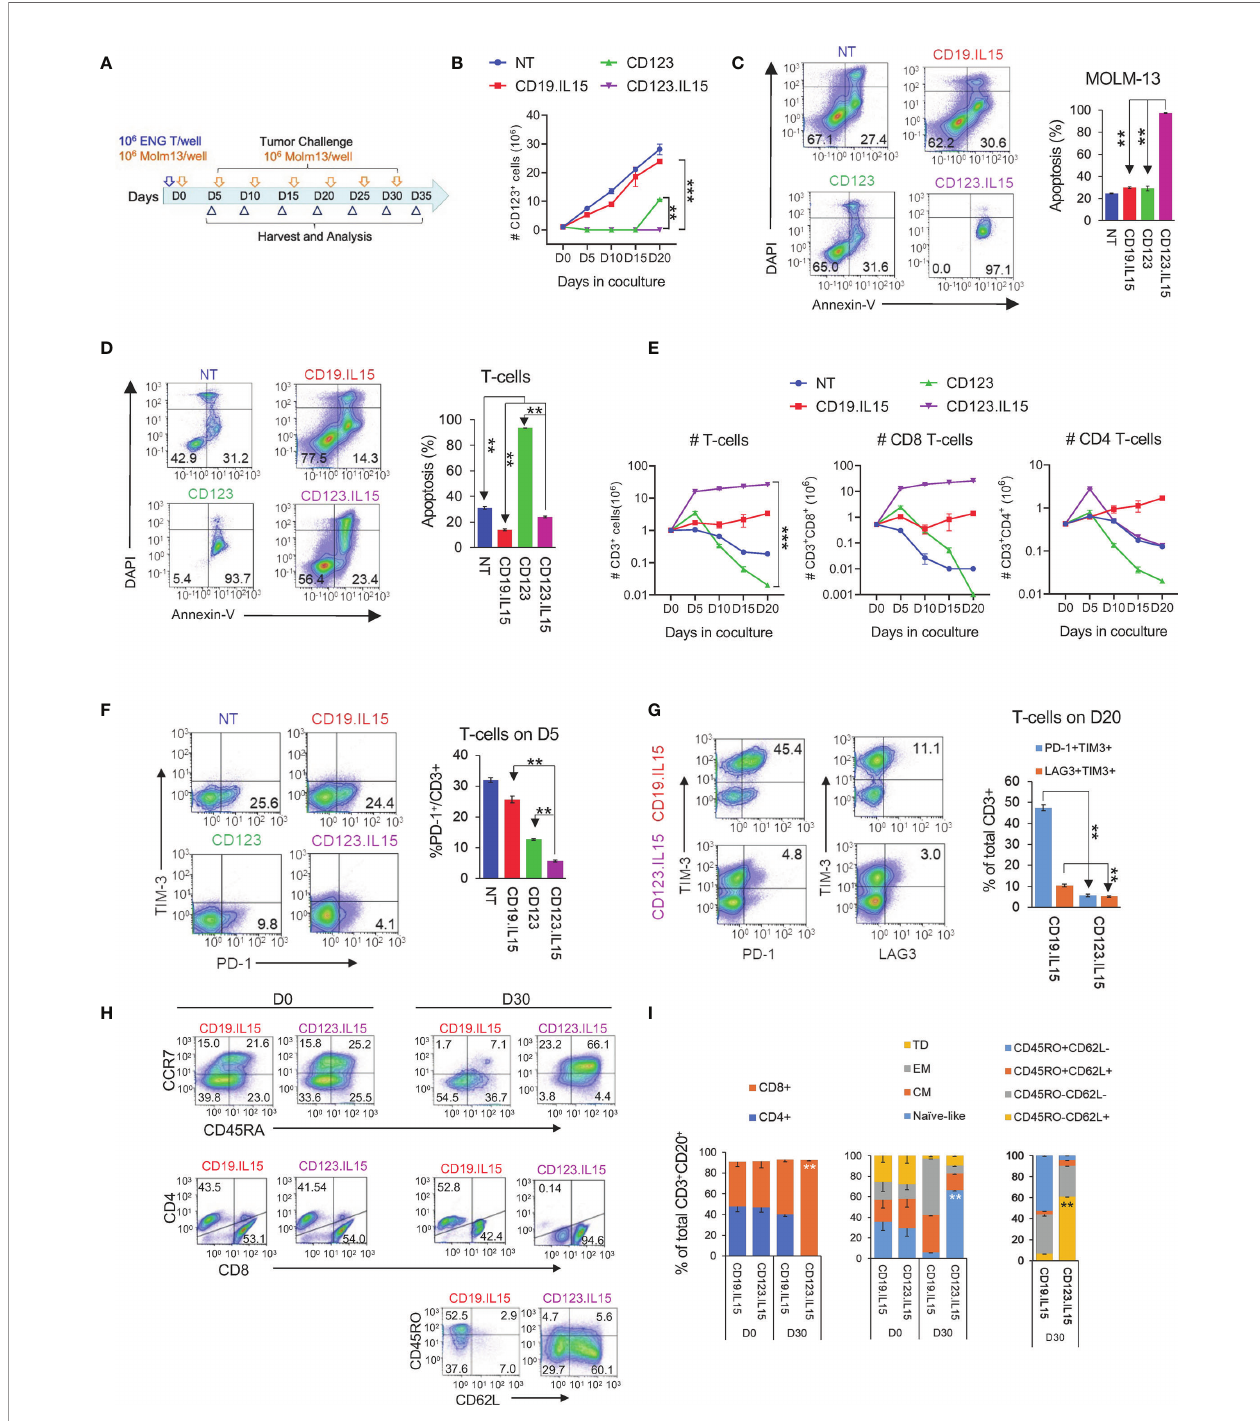
FIGURE 2 | Transgenic Expression of IL15 improves effector function of CD123-ENG T-cells. (A) Scheme of repeat stimulation assay. AML cells and T cells in co-cultures were enumerated using counting beads by fl ow cytometry prior to each re-challenge. (B) CD123 + MOLM-13 AML cell count from the repeat stimulation assay prior to the 2nd (D5), 3rd (D10), 4th (D15), and 5th (D20) stimulation. (C, D) Apoptosis measured by Annexin-V + DAPI - fl ow cytometry (C) of AML and (D) T-cells on day 20. Representative fl ow cytometry plots and summary data are shown. (E) CD3 + , CD8 + , and CD4 + , T-cell counts (log10) in coculture assay overtime. (F) PD-1 and TIM3 expression in T-cells on day 5. Left panel: representative fl ow cytometry plots gated on CD3 + T-cells. Right: summary data. (G) Expression PD-1, TIM3, and LAG-3 in T-cells on day 20. Left panel: representative fl ow cytometry plots gated on CD3 + T-cells. Right: summary data. (H, I) Phenotypic analysis on CD3 + CD20 + of CD123.IL15 and CD19.IL15 T-cells before and on day 30 of co-culture. (H) Representative fl ow cytometry plots. (I) Summary data, n = 3 for all data shown in panels; data are shown as mean ± SE, ***:p <0.001, **:p <0.01, t